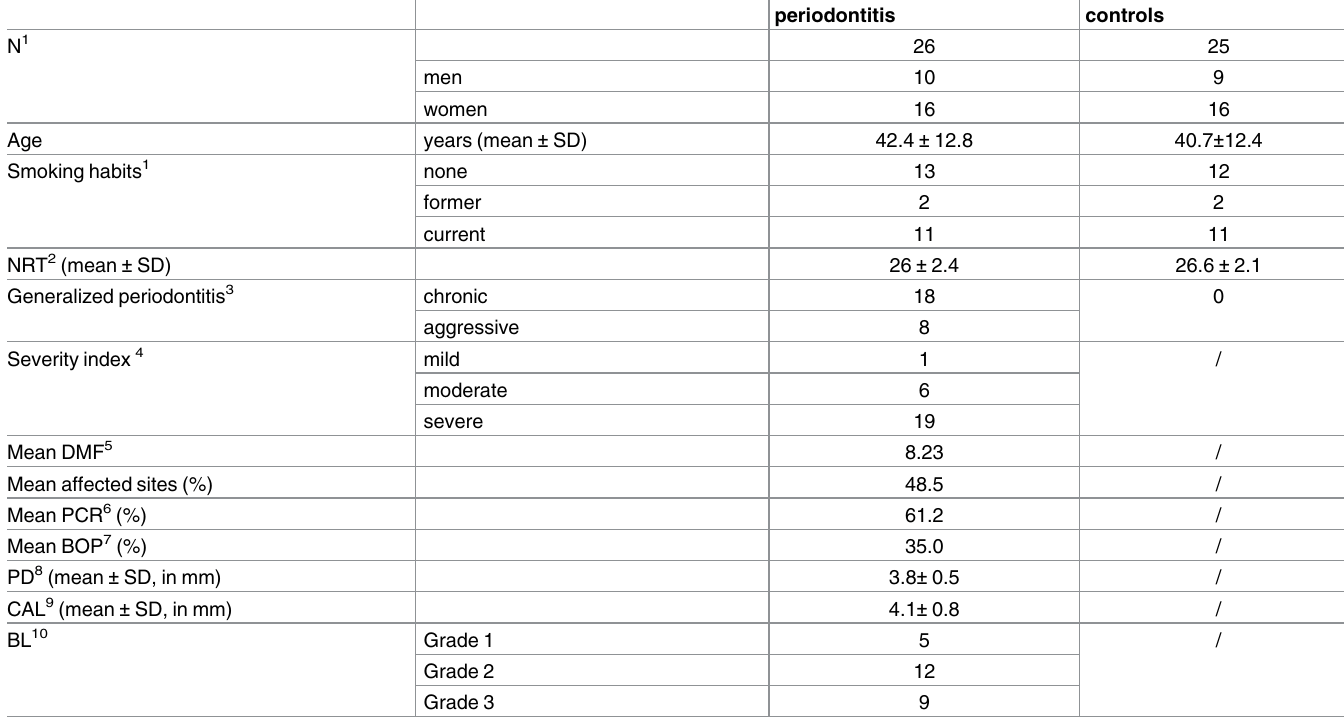
Table 1. Clinical data of patients with periodontitis and